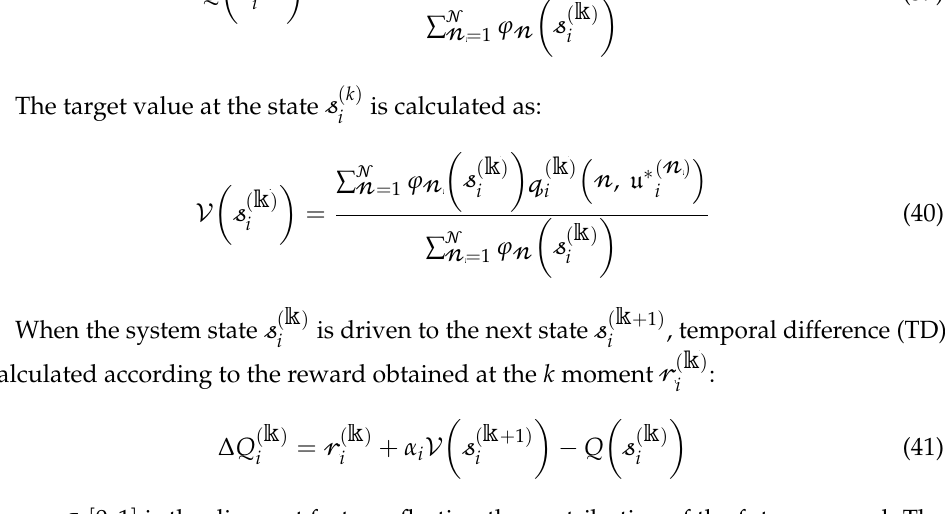
Figure 2. Membership function of fuzzy input of the 𝑖 (cid:3047)(cid:3035) subsystem.